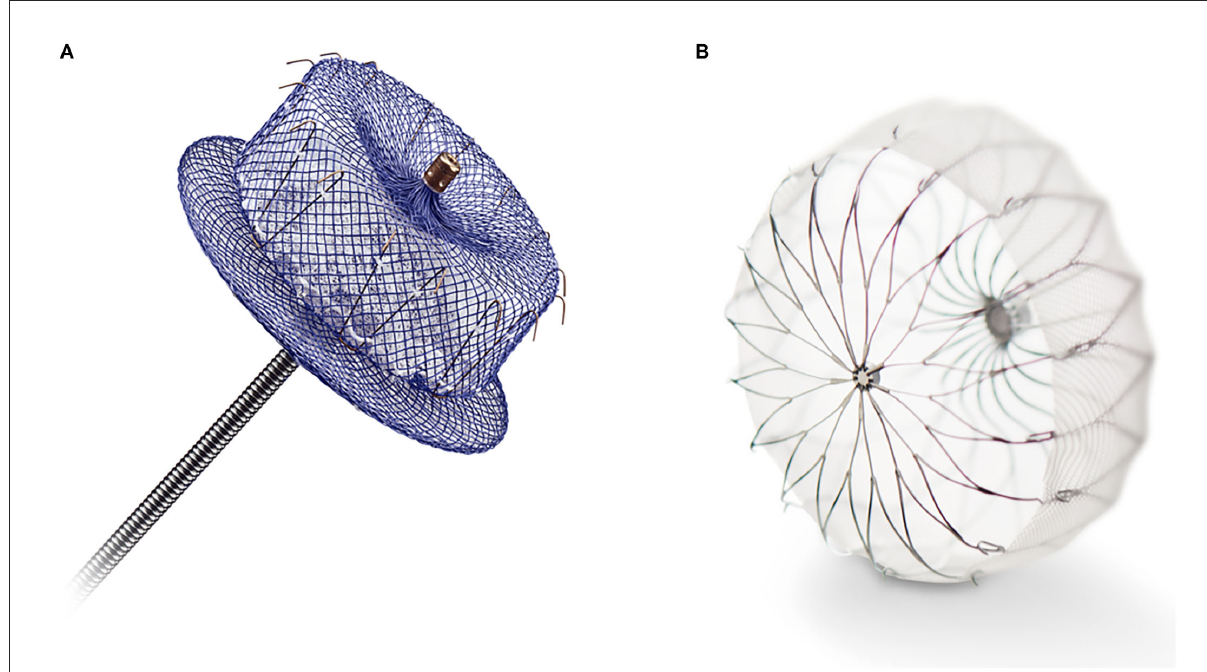
FIGURE2 (A) The Amplatzer AMULET Left Atrial Appendage Occluder (Abbott, Abbott Park, Illinois, USA). (B) The WATCHMAN FLX LAA system (Boston Scientific, Marlborough, Massachusetts, USA).